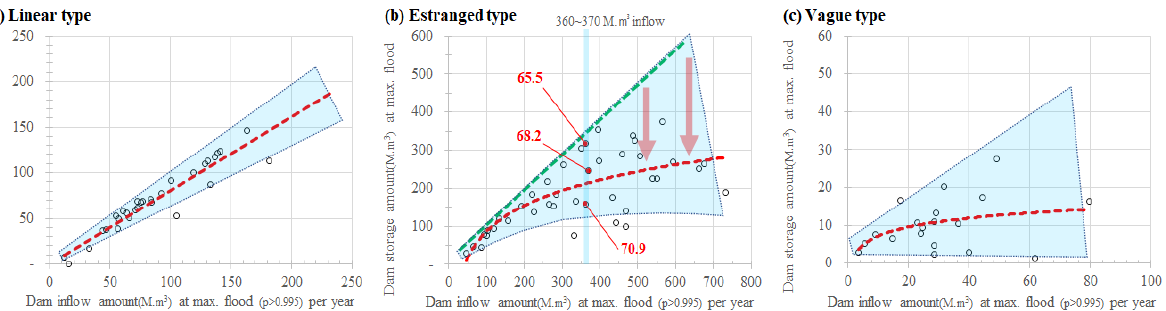
Figure 6. Three type of RSF scatter plot: ( a ) Linear type; ( b ) Estrange type; ( c ) Vague type, red dot line indicates average RSF curve, and the green dot line denotes the high threshold line of RSF curve.